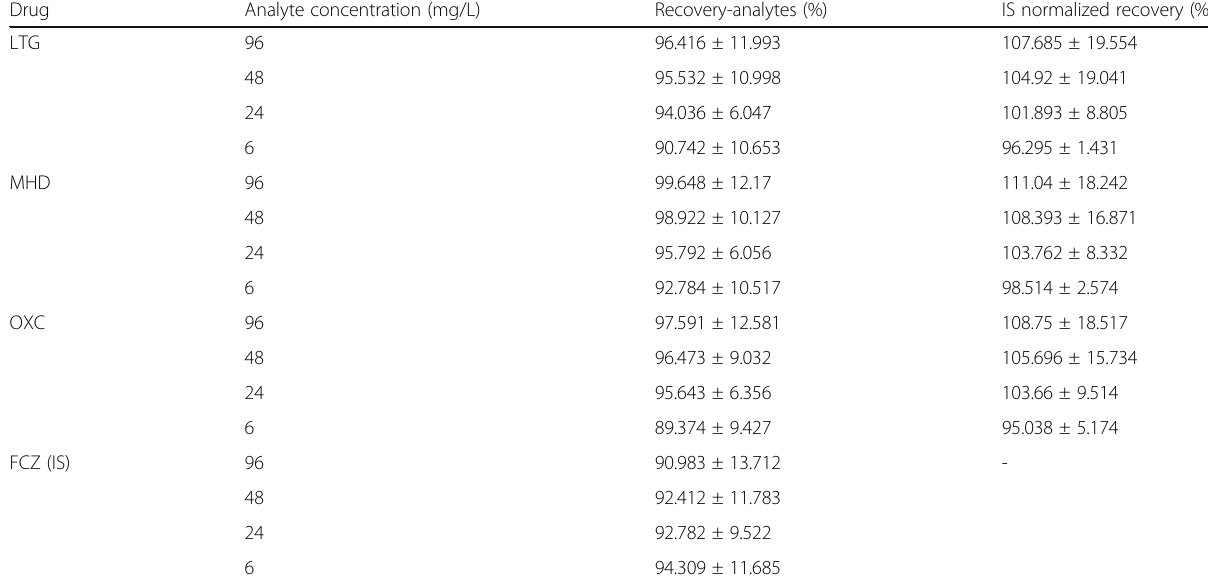
Table 2 The recovery of LTG, MHD, and OXC in human blood plasma (mean ± standard deviation, n = 6) Drug